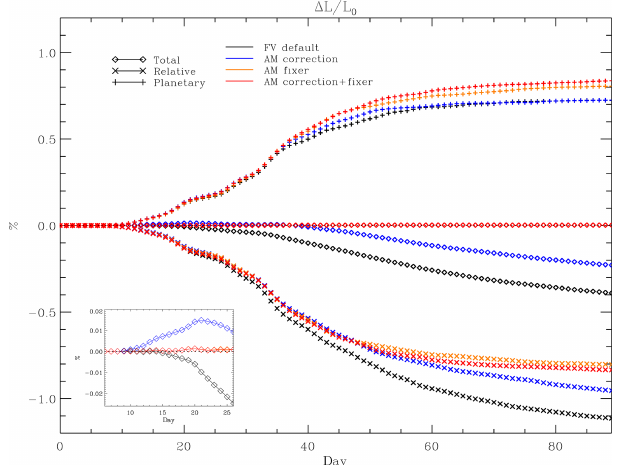
Figure 3. AM correction and fixer in adiabatic, frictionless baro- clinic wave tests. Three sets of curves are shown for each of four different simulations with CAM FV, indicating the time evolution of global AM (diamond shapes) and its two components of plane- tary AM (vertical crosses) and relative AM ( × crosses) in each sim- ulation. Total AM and each AM component are normalised to the initial total AM of the initial state, and differences with respect to initial values are shown, expressed in percentage. Standard CAM– FV is shown in black, CAM–FV with the AM correction only in blue, CAM–FV with the AM fixer only in yellow, and CAM–FV with both the AM correction and fixer in red. The inset panel on the lower right of the figure shows an enlargement for the initial evolu- tion of total AM. Note that the four simulations are nearly indistin- guishable before day 8, i.e. during the linear phase of the baroclinic wave. All simulations are run on the 2 ◦